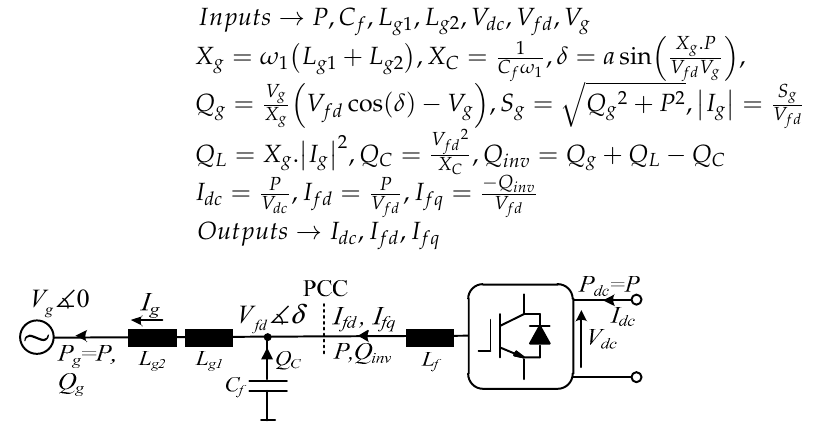
Figure 5. Power flow diagram in a grid-connected VSC.